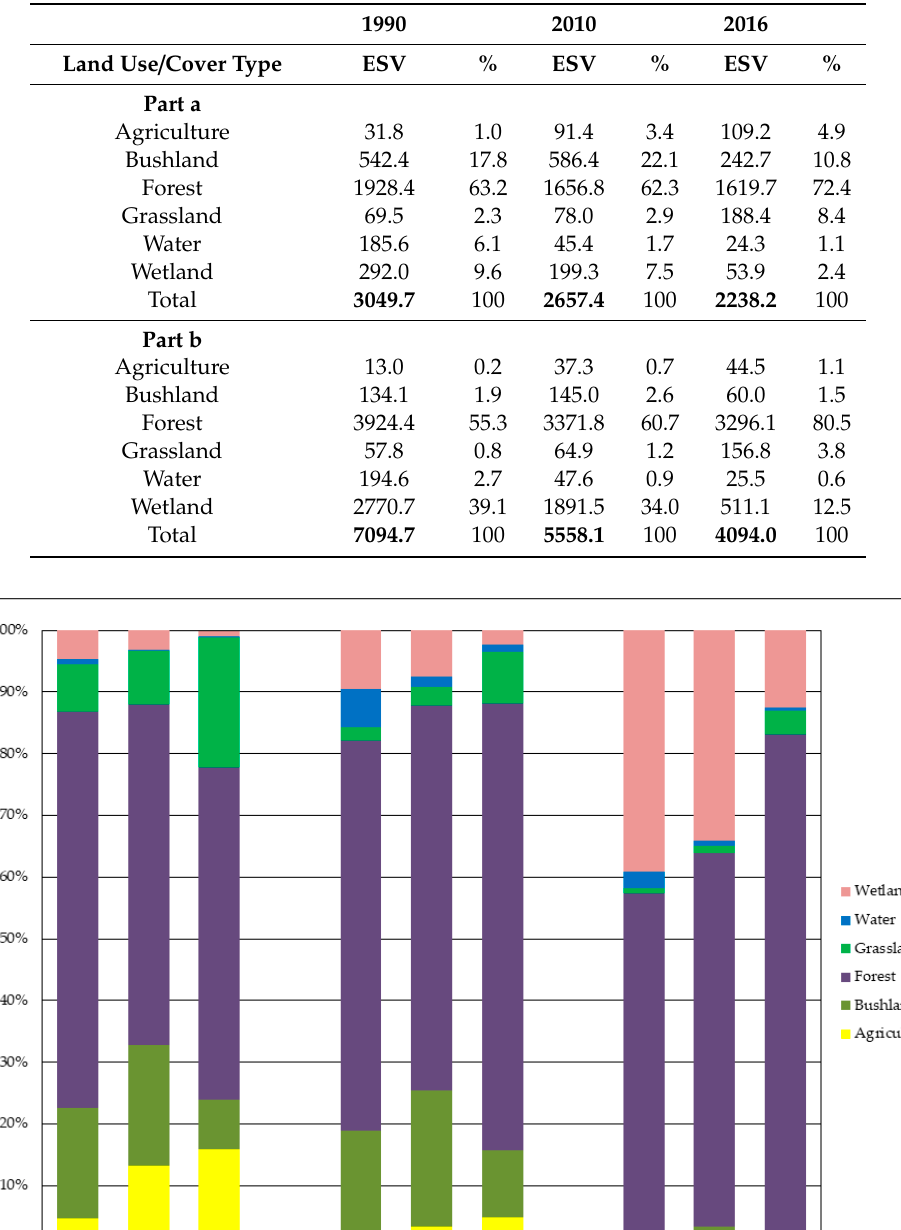
Table 3. Results of the estimated ecosystem service values per LULC type in the Kilombero Valley floodplain in (1994 US$ million per year) for 1990, 2010 and 2016 using (Part a) adopted modified local value coe ffi cients from Kindu et al. and Temesgen et al. [7,33], with permission from Elsevier, 2016 and MDPI, 2018, respectively (Part b) global value coe ffi cients Costanza et al. [1], with permission from Nature research, 1997.